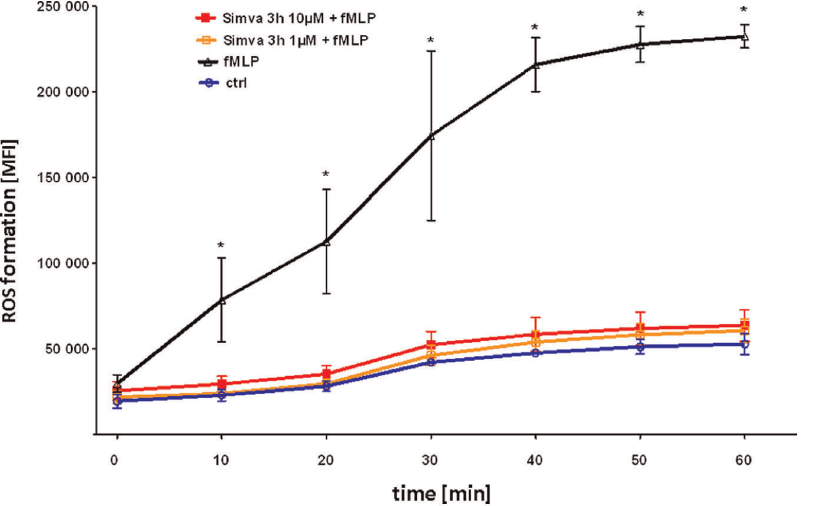
Figure 4. Simvastatin blocks ROS formation in neutrophils. Isolated human neutrophils were pre-treated with Simvastatin (3 hours, 1 or 10 m M), stained with ROS-sensitive H2-DCFDA and then activated with fMLP. In addition, neutrophils were pre-treated with simvastatin as indicated and fluorescence was measured by flow cytometry FACS Canto (Becton Dickinson, San Jose, CA) every ten minutes following fMLP stimulation. n=6 for each group; repetition=4. Statistical significance was tested using one way ANOVA with Newman-Keuls Multiple Comparison test. * indicates significant difference in comparison to the control group at each different time point.